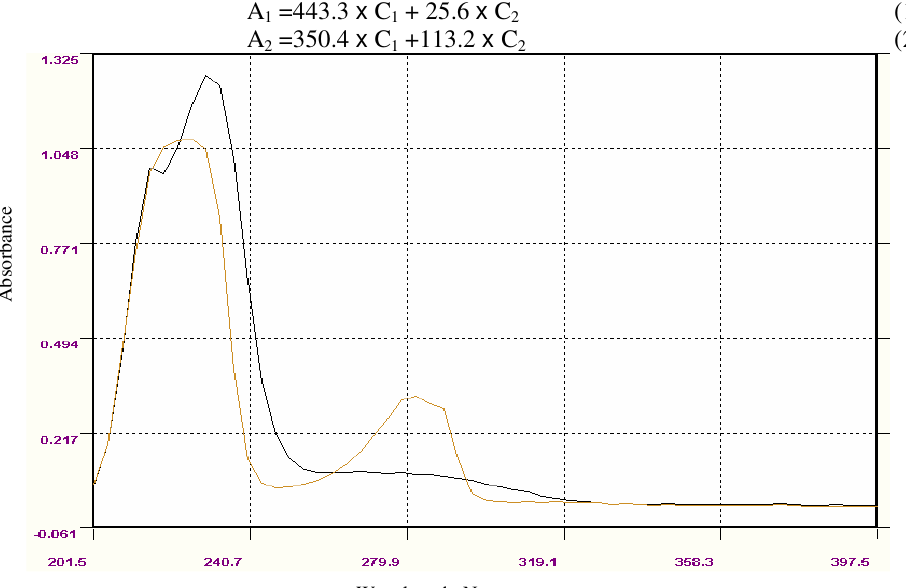
Figure 1. Zero order overlain spectra of CTZ (10 mcg/mL) and DXM (10